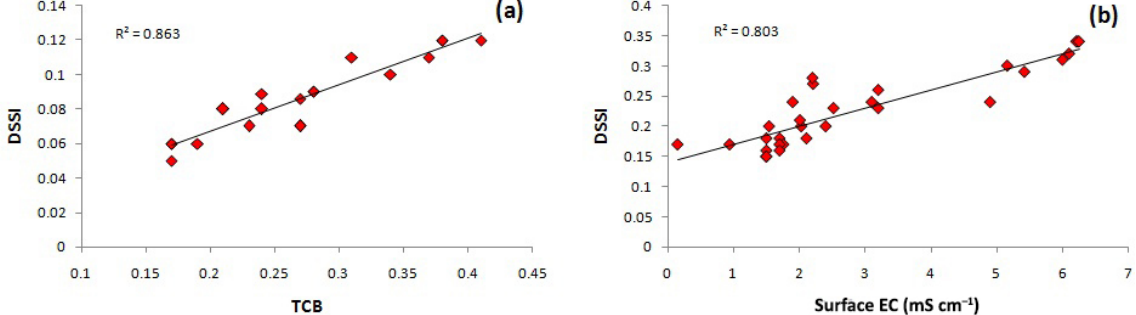
Figure 4. (a) The Diagonal Soil Salinity Index (DSSI) model confirms theoretical accuracy with Tasseled Cap brightness index (TCB) ( R 2 = 0 . 863). (b) The linear regression between DSSI and surface electrical conductivity (EC) ( R 2 = 0 . 803) which ensures the ground reliability of the